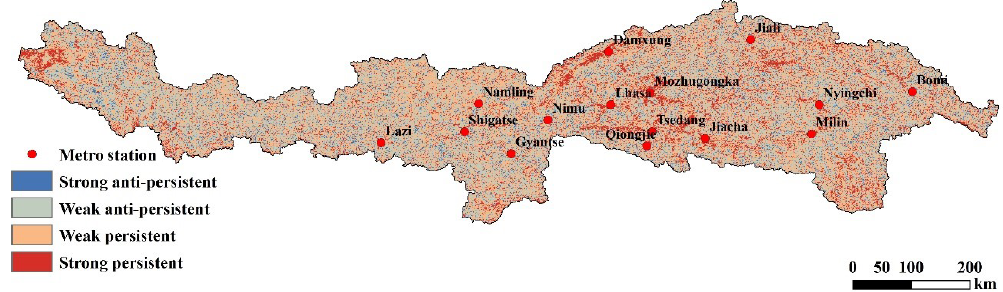
Figure 5. The spatial distribution of Hurst index of monthly NDVI in the Yarlung Zangbo River Basin.